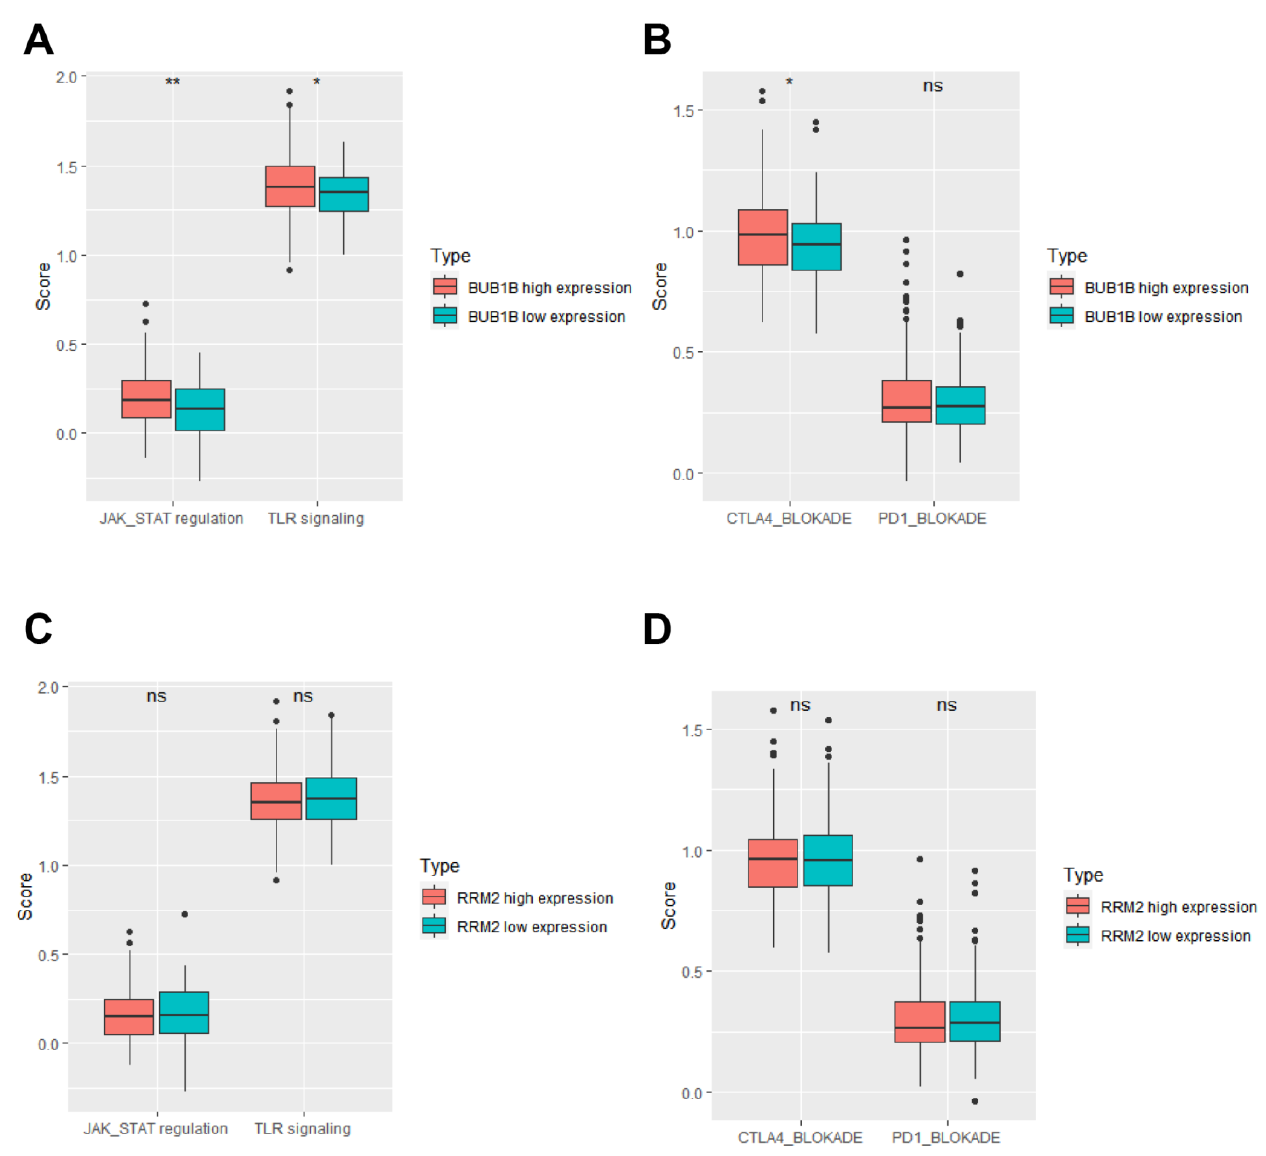
Figure 5. Analysis of the relationship between inflammatory signaling and cancer therapy gene sets with the expression of BUB1B and RRM2 in TCGA-LIHC cohort. ( A , B ) Comparison of JAK-STAT regulation gene sets, TLR signaling gene sets, and CTLA4 and PD1 blockade cancer immune therapy gene sets between BUB1B high expression group and BUB1B low expression group. ( C , D ) Comparison of JAK-STAT regulation gene sets, TLR signaling gene sets, and CTLA4 and PD1 blockade cancer immune therapy gene sets between RRM2 high expression group and RRM2 low expression group. * p < 0.05; ** p < 0.01 .